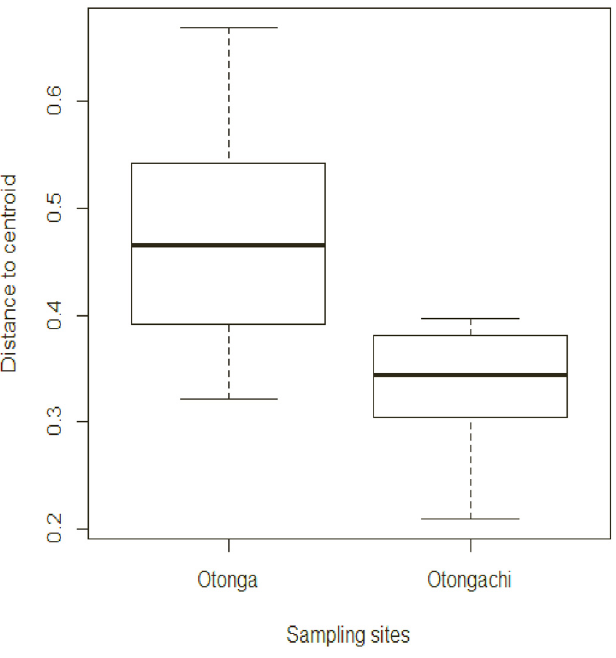
Figure 13. Distribution of the abundance of species in the plots of Otonga or Otongachi with respect to the distance from the centroid identified by PCoA analysis.